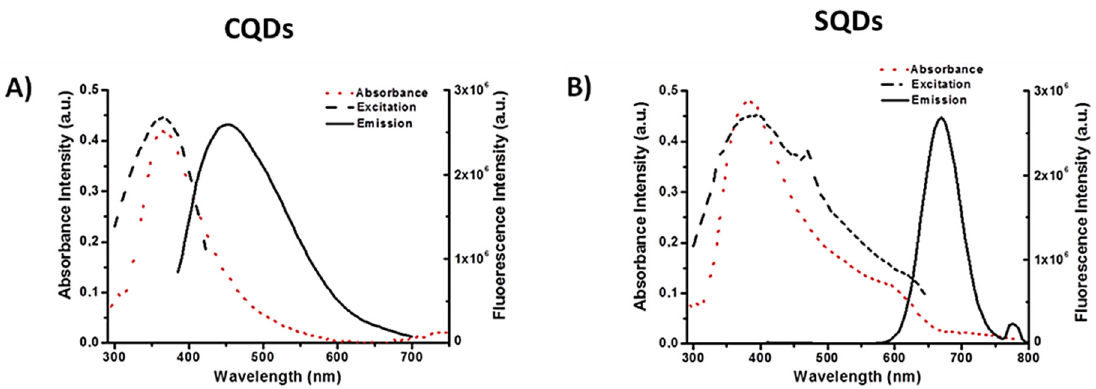
Figure 1. Absorbance and emission curves at their maximal excitation wavelengths of ( A ) graphitic-carbon quantum dots (CQDs) and ( B ) semiconductor quantum dots (SQDs). [Nanodots] = 200 mg·L − 1 ; slit widths at emission and excitation were set at 3 and 8 nm, respectively.